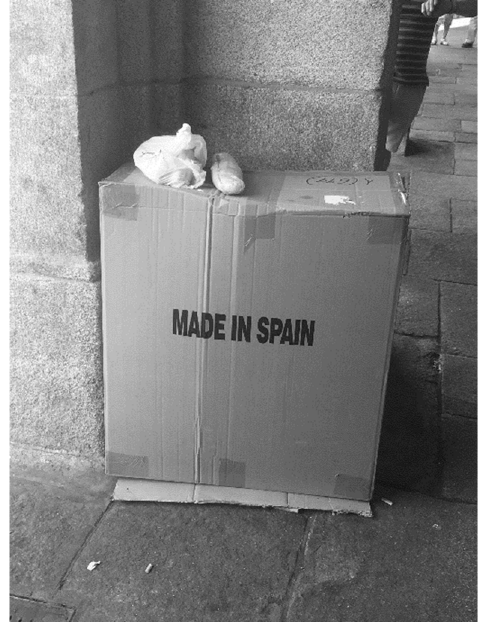
Figure 2. A makeshift shelter in Madrid, Spain.